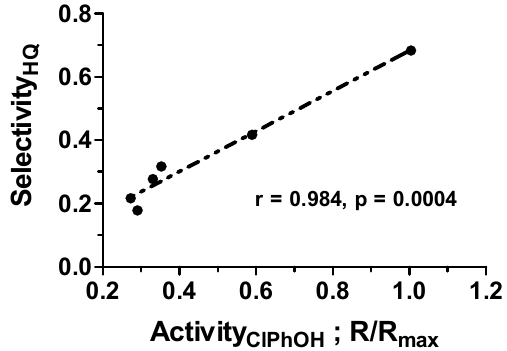
Figure 8. Correlation between activities of six tested TiO 2 photocatalysts in the photodegradation of 4-chlorophenol and their selectivity toward formation of hydroquinone. Reproduced with